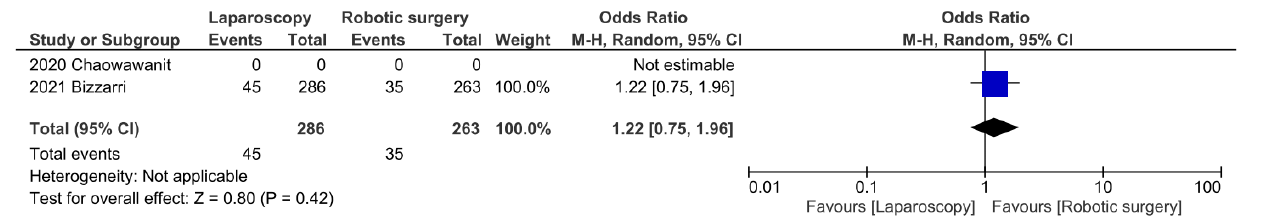
Figure 6. Forest plot of individual and pooled odds ratios, with 95% confidence interval (CI), for number of dissected SLN: 1, comparing laparoscopy and robotic surgery for SLN biopsy in EC women.